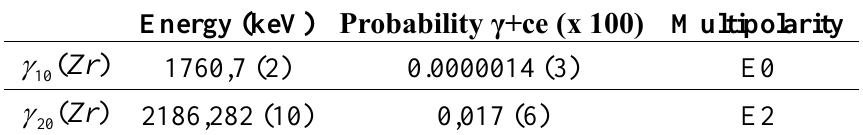
Table 3. Gamma transitions of 90 Y, including conversion electron